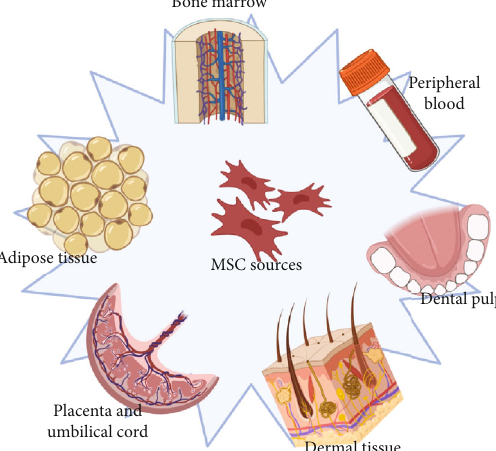
Figure 1: Sources of mesenchymal stem cells. Created with http://